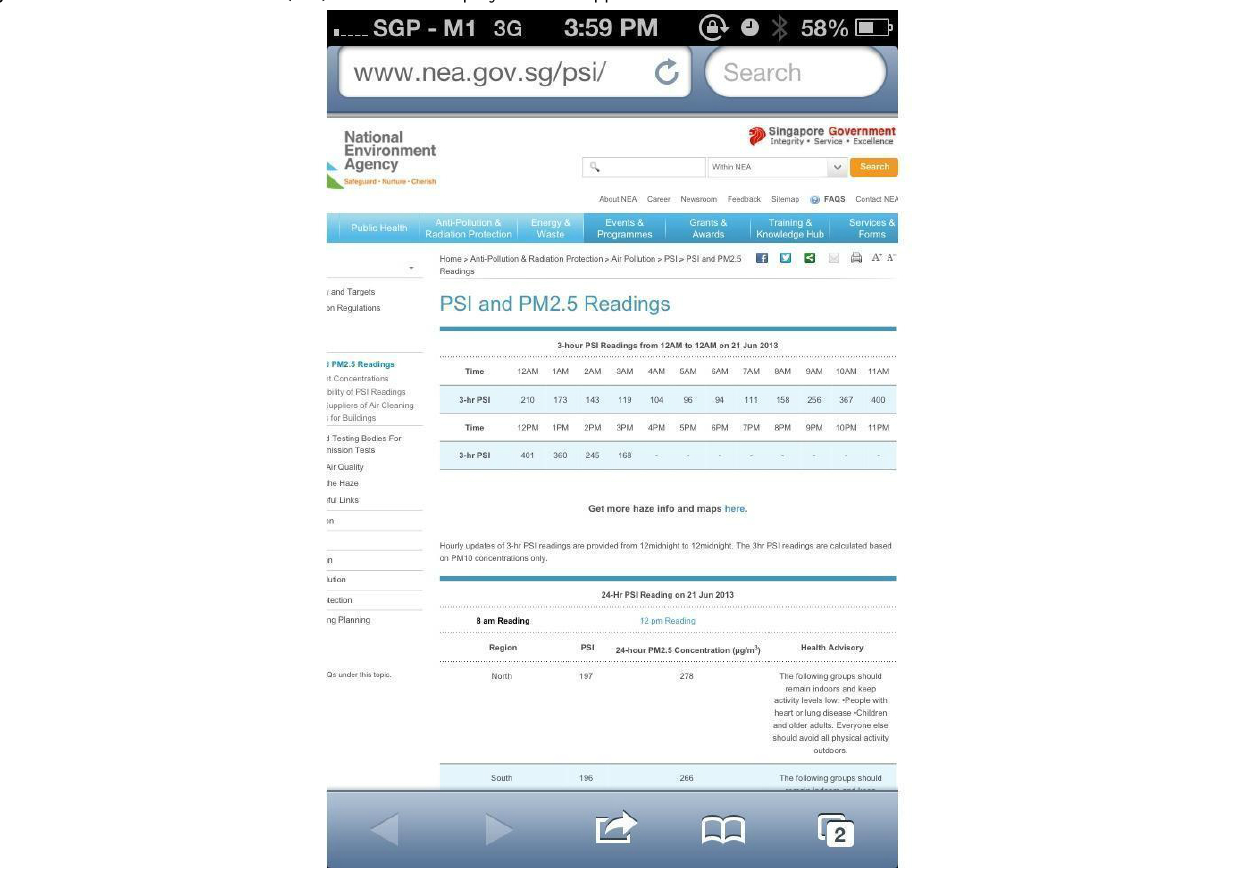
Figure 2. Pollutant Standard Index (PSI) information displayed within